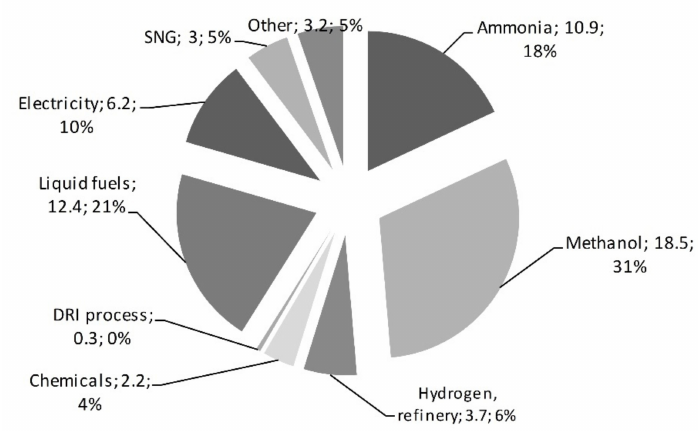
Figure 1. Gasification process syngas use (million m 3 /h)